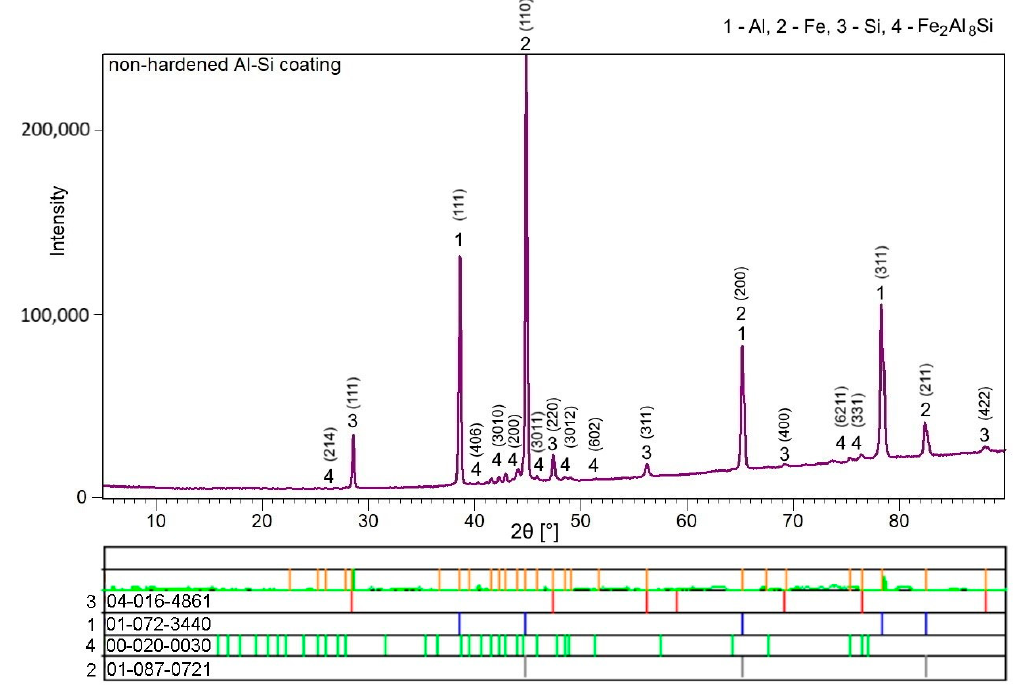
Figure 3. XRD pattern of the Al-Si hot-dipped coating on as-received 22MnB5 boron steel.